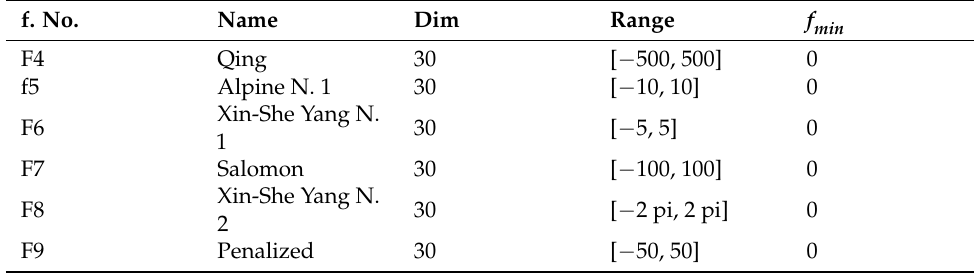
Table 3. Multimodal benchmark